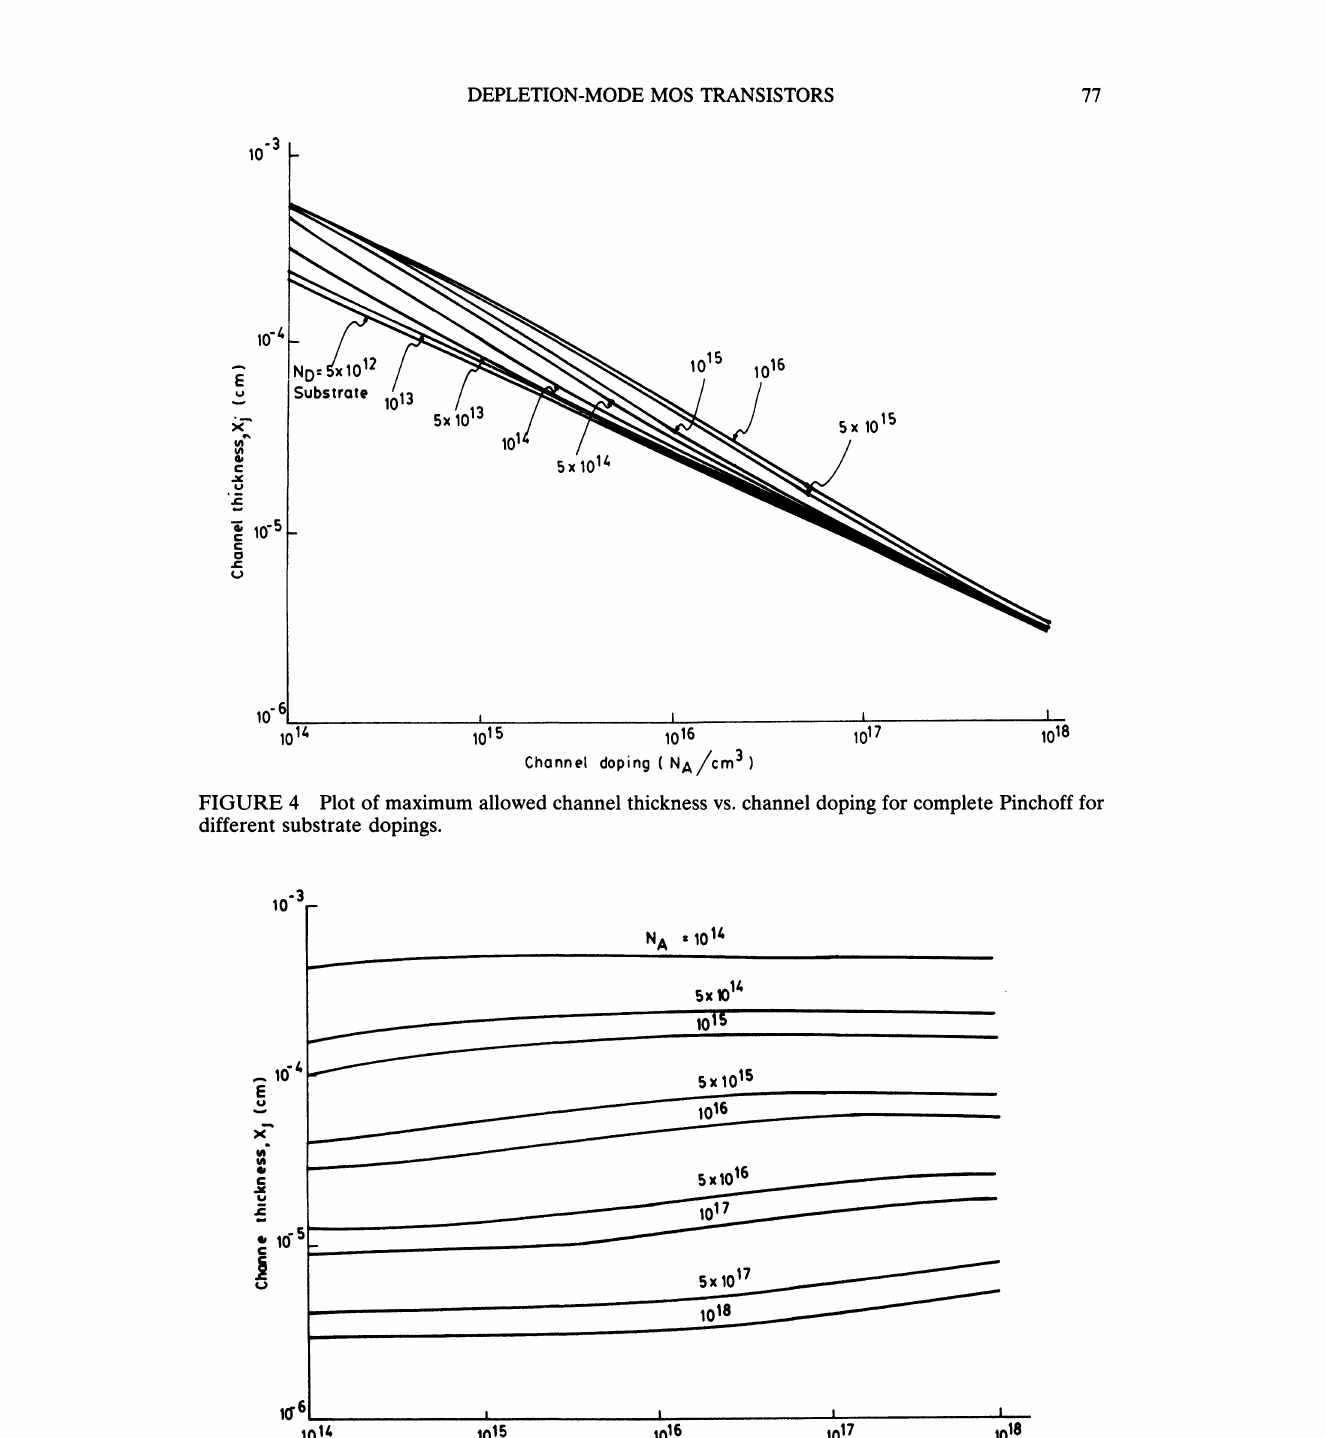
FIGURE 5 Plot of maximum allowed channel thickness vs substrate doping for complete Pinchoff for different channel